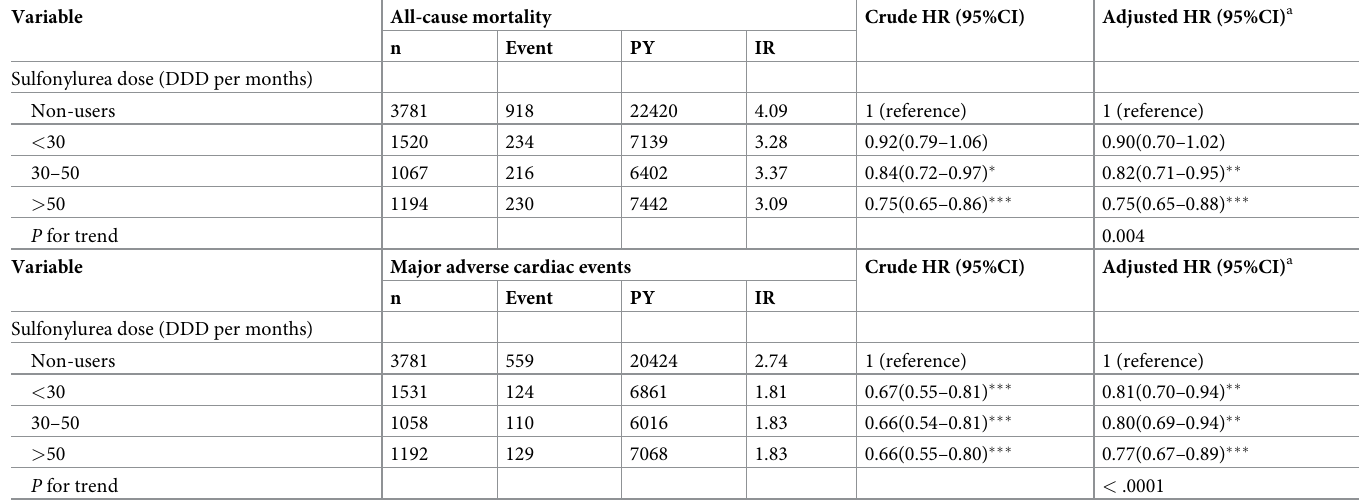
Table 3. Hazard ratios and 95% confidence intervals for all-cause mortality and cardiovascular events associated with cumulative average dose of